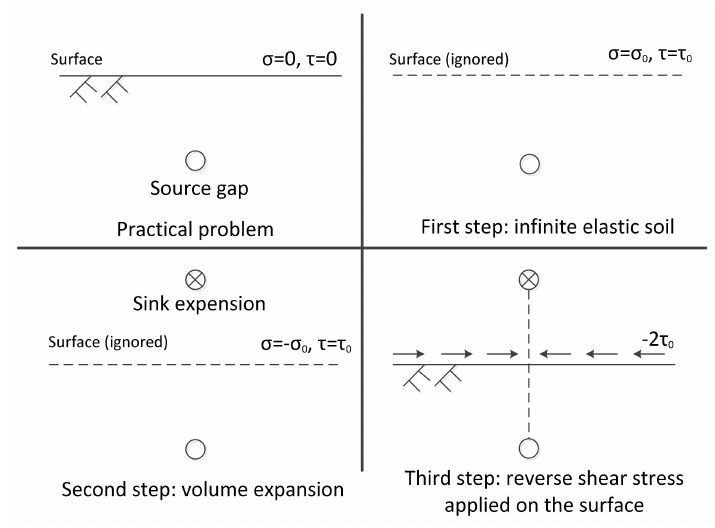
Figure 3. Analysis steps of mirror source–sink